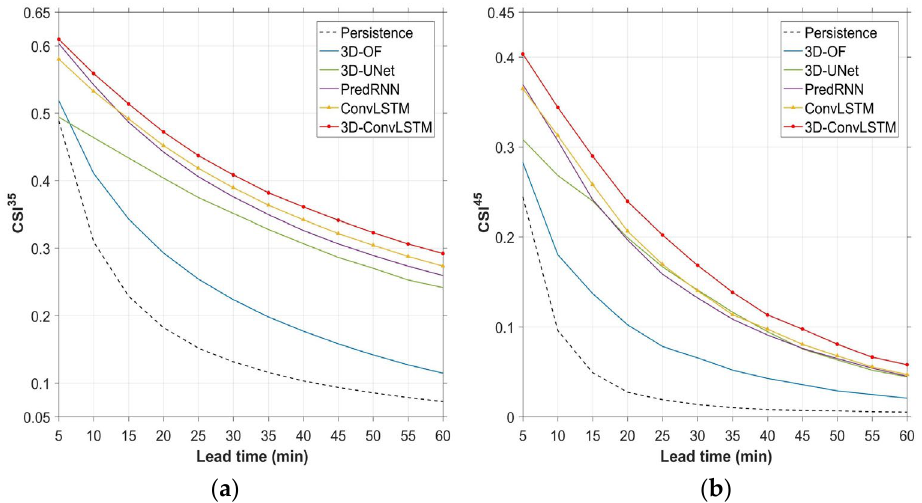
Figure 3. Critical success index ( CSI ) curves against different lead times at ( a ) 35 dBZ threshold and ( b ) 45 dBZ threshold.